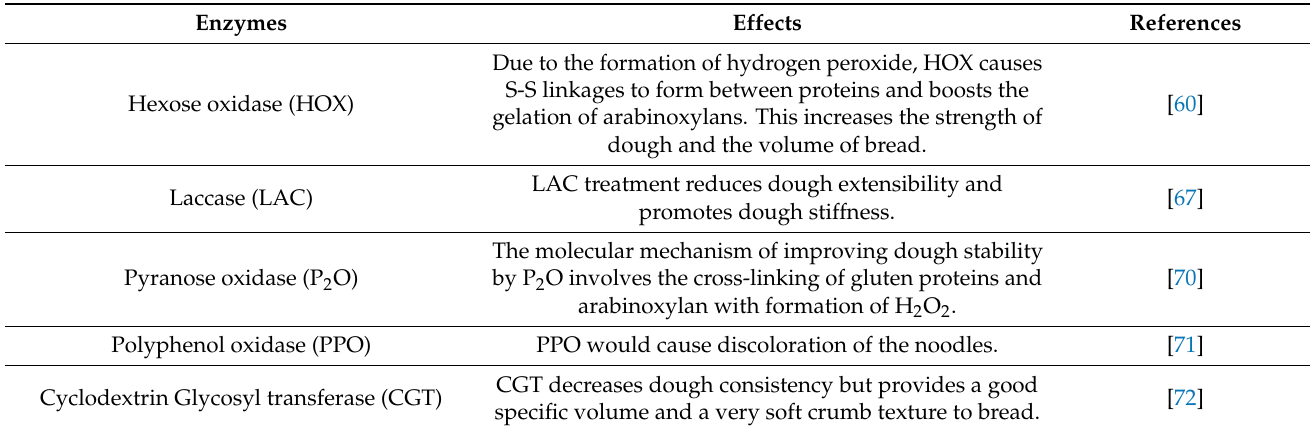
Table 2. Enzymes widely used in wheat